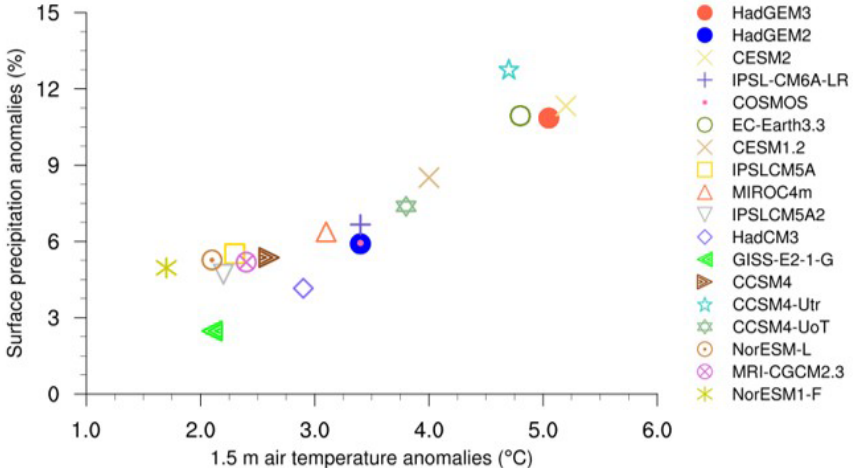
Figure 14. Global annual mean surface precipitation anomalies (expressed as a percentage) versus global annual mean SAT from HadGEM3 mPWP simulation, HadGEM2 and all other models in